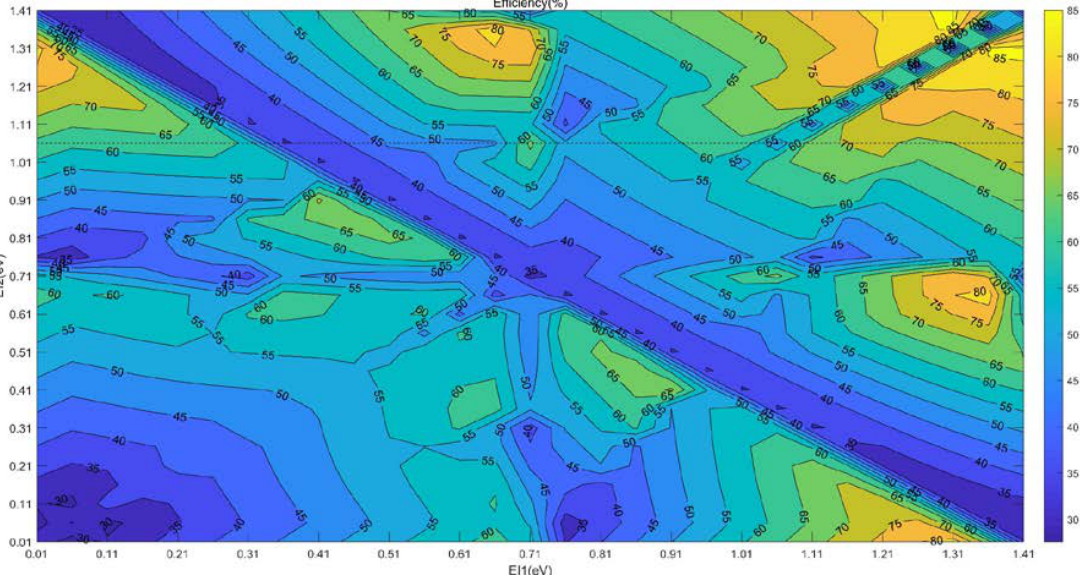
Figure 3. Efficiency contour plot of dual intermediate bands. The right color gradient bar shows the efficiency.